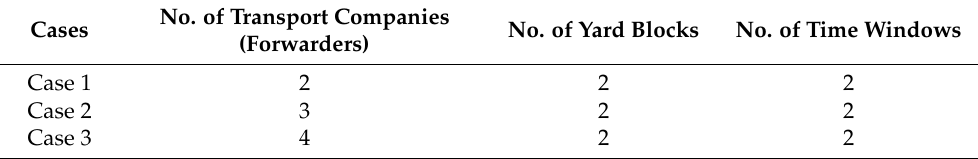
Table 4. Cases for the change in the number of transport companies (forwarders).